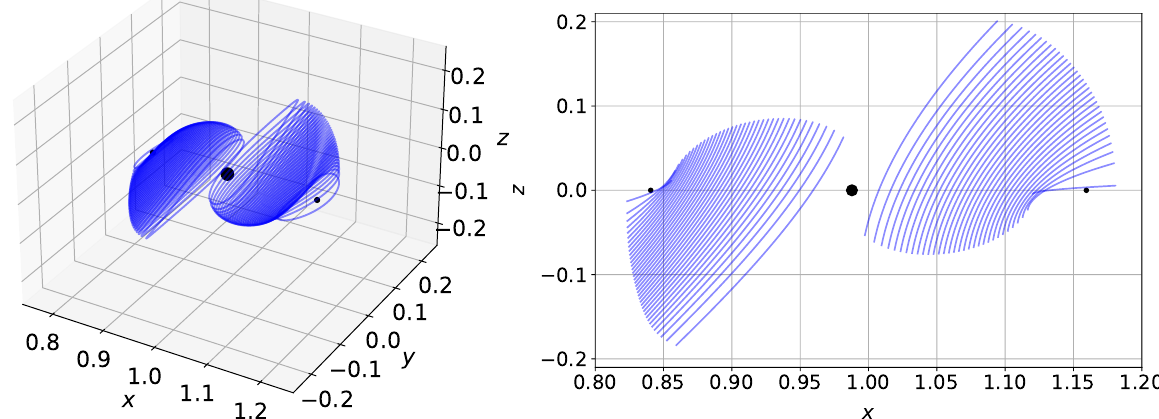
Figure 9. Halo orbits of the “northern” bifurcation around both L1 and L2 Lagrange